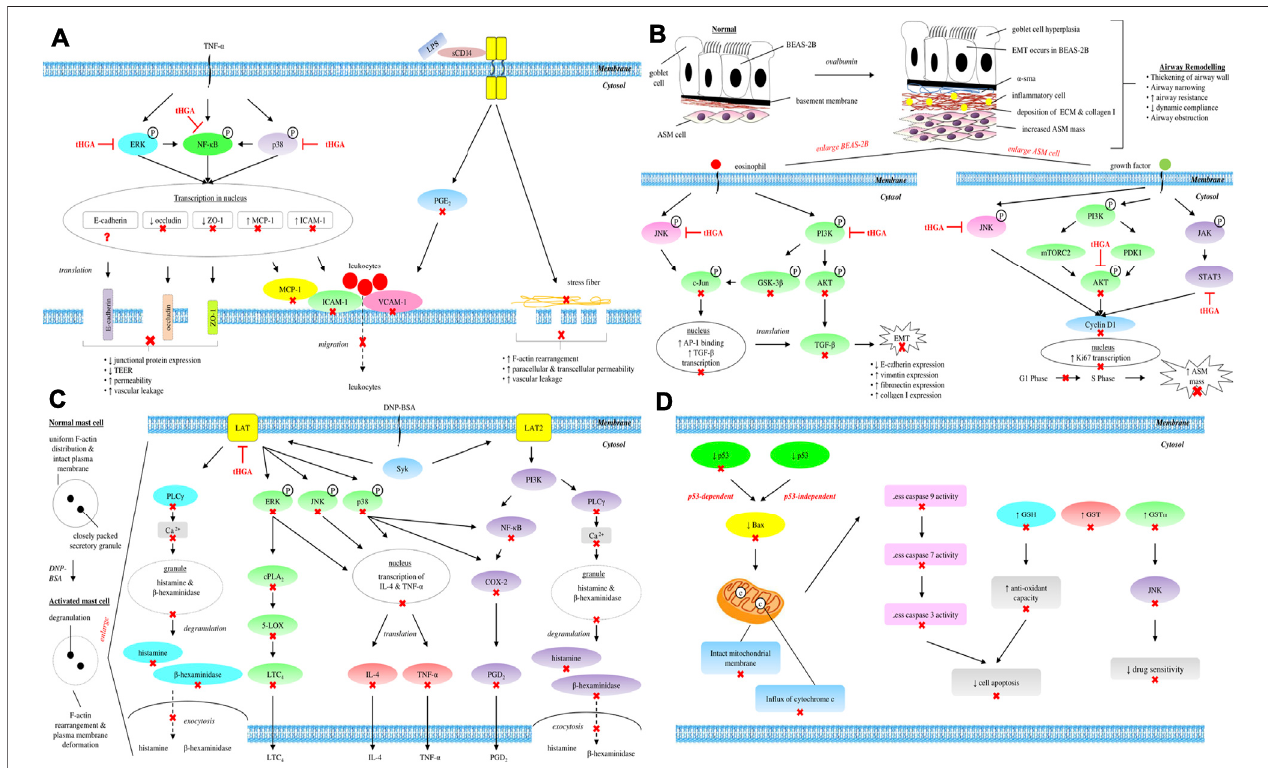
FIGURE1| Overallmechanismsandsignalingpathwaysunderlying (A) endothelialandepithelialbarrierprotective, (B) anti-asthmatic, (C) anti-allergic,and (D) anti- x × cancer activities of tHGA. , molecular targets of tHGA; , downstream molecules inhibited by tHGA; ? , unknown effect.